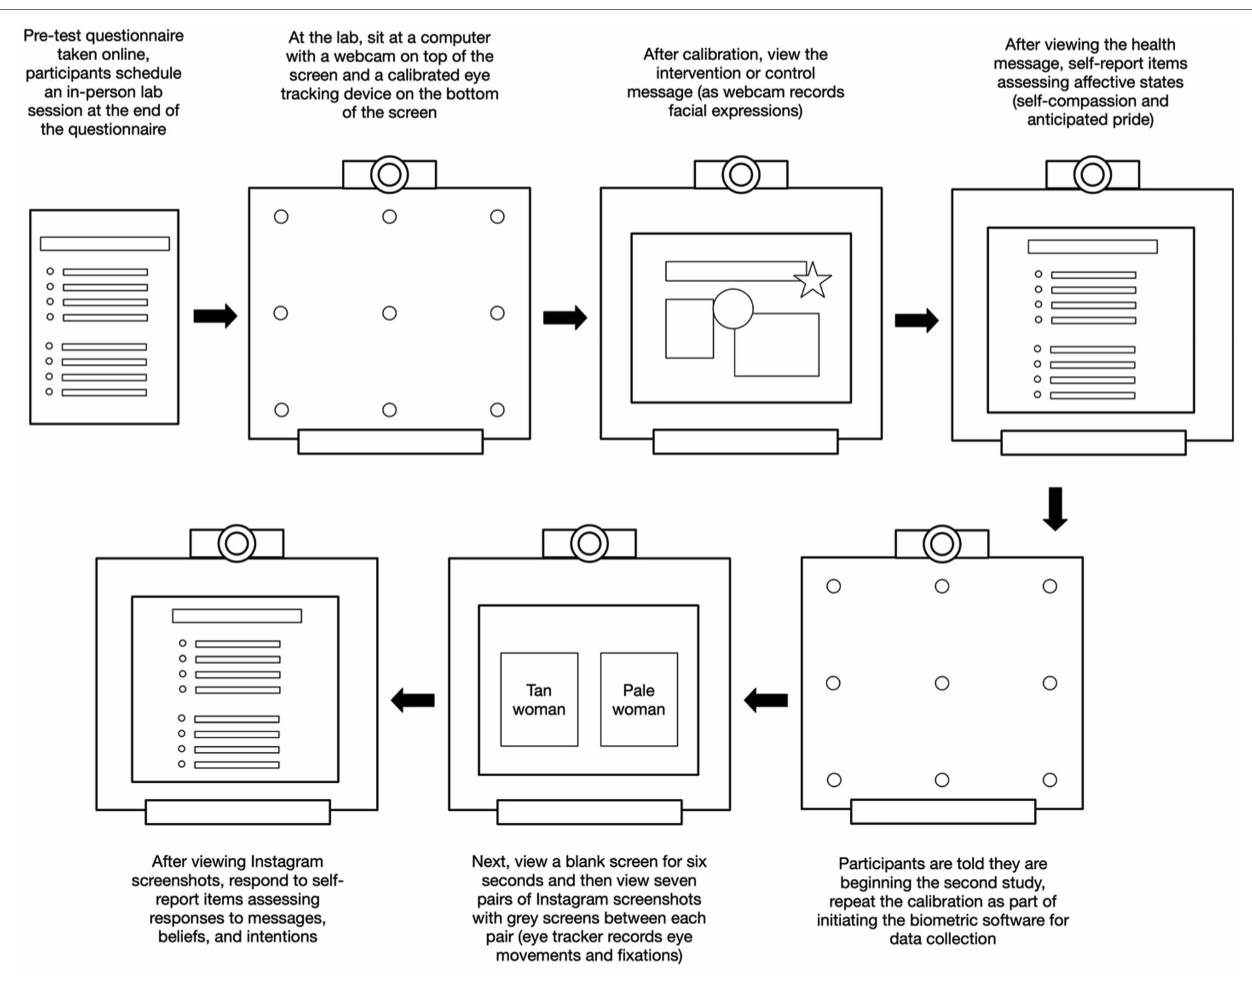
FIGURE 1 | Procedures